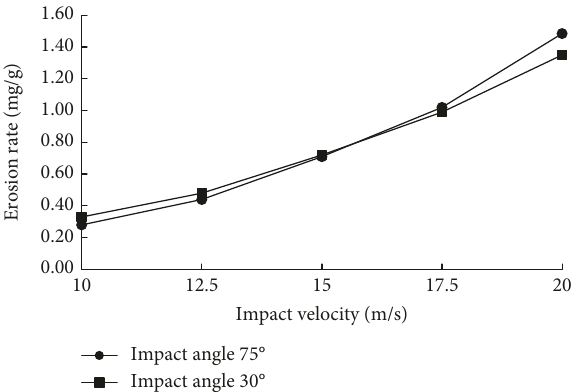
Figure 9: Effect of impact velocity on the erosion rate.